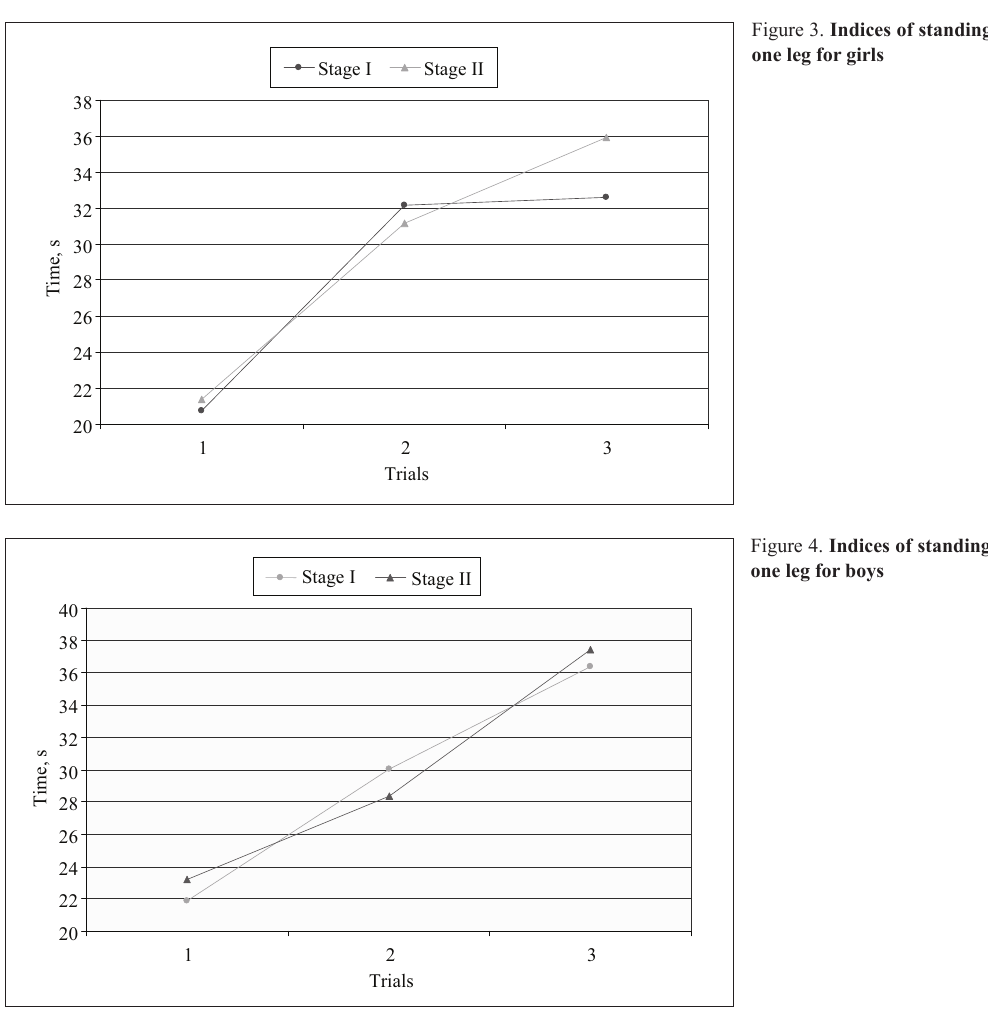
Table 6. Changes in the indices of psychomotor reactions for boys and girls in junior group of dancers Figure 4. Indices of standing on the front foot of one leg for boys Girls Boys Simple reaction time, ms Complex reaction time, ms Simple reaction time, ms Complex reaction time, ms Left hand Right hand Left hand Right hand Left hand Right hand Left hand Right hand